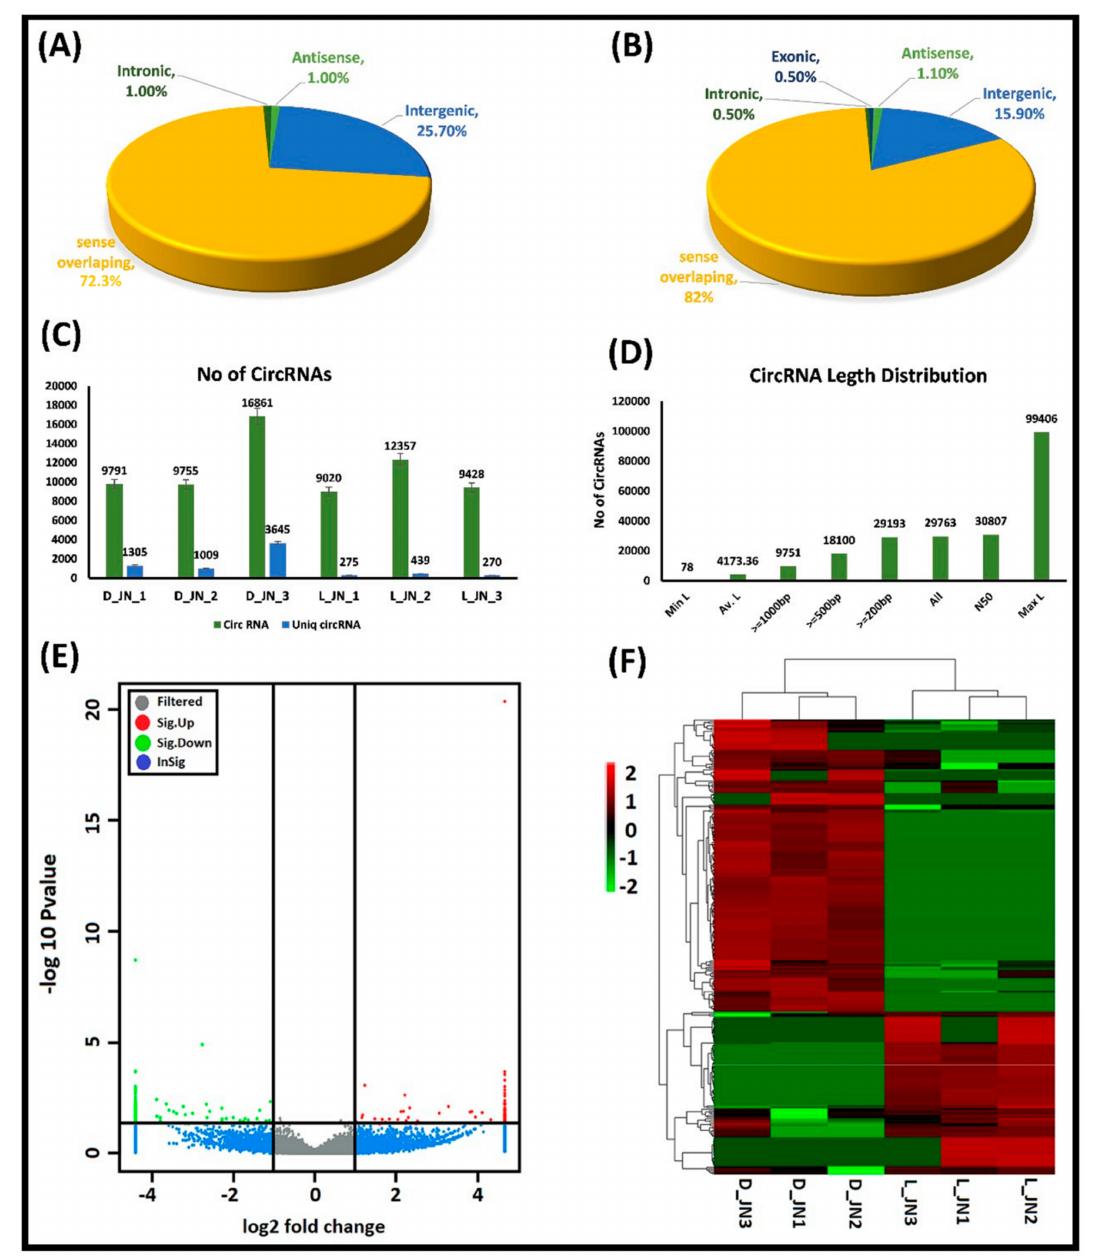
Figure 1. The proportions, characteristics, and distributions of various circRNAs identified in the IMF tissues of two pig breeds. Classifications of the DECs are given as: ( A ) upregulated and ( B ) downregulated; ( C ) represents the number of circRNAs predicted in L_JN and D_JN; ( D ) shows the length distributions of the identified circRNAs; ( E ) illustrates the upregulated circRNAs with red dots on the right side and downregulated with green dots, while grey represents the circRNAs with non-significant expression differences between both groups of pig breeds under |fold change| ≥ 2.0 and p -value < 0.05; ( F ) shows the cluster analysis of DECs. The expression data were clustered with a log10 (TPM + 1) value. The color scale indicates the expression of DECs: red and green indicate up- and downregulation, respectively. D_JN and L_JN represent two different pig